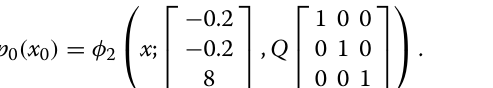
x n ,3 = x n − 1,3 + (cid:10) t